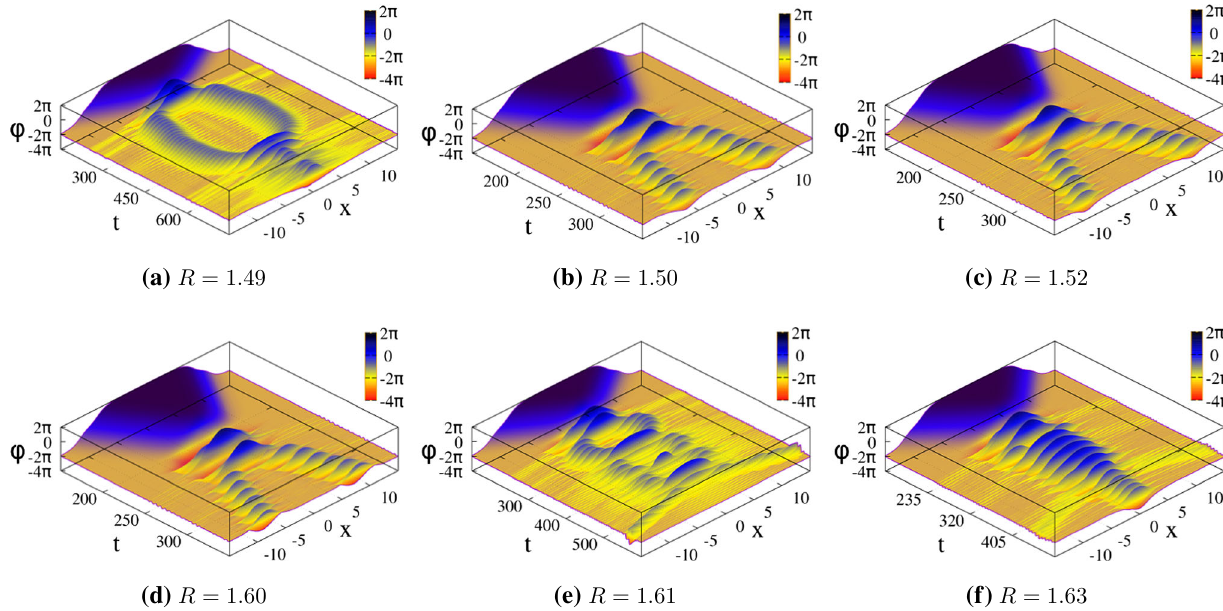
Fig. 8 Space-time picture of the kink–antikink collisions for some R ’s from the range 1 . 49 ≤ R ≤ 1 .